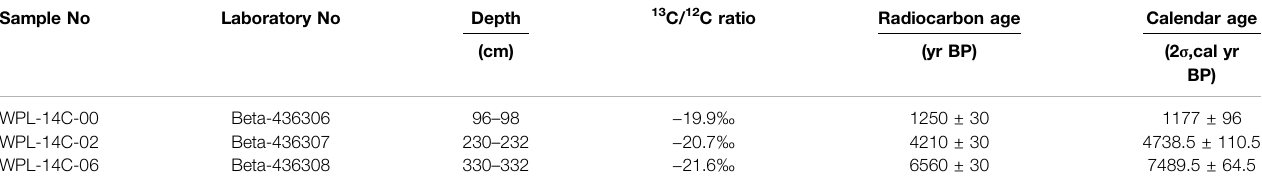
TABLE 2 | 14 C dates for the WPL pro fi le.